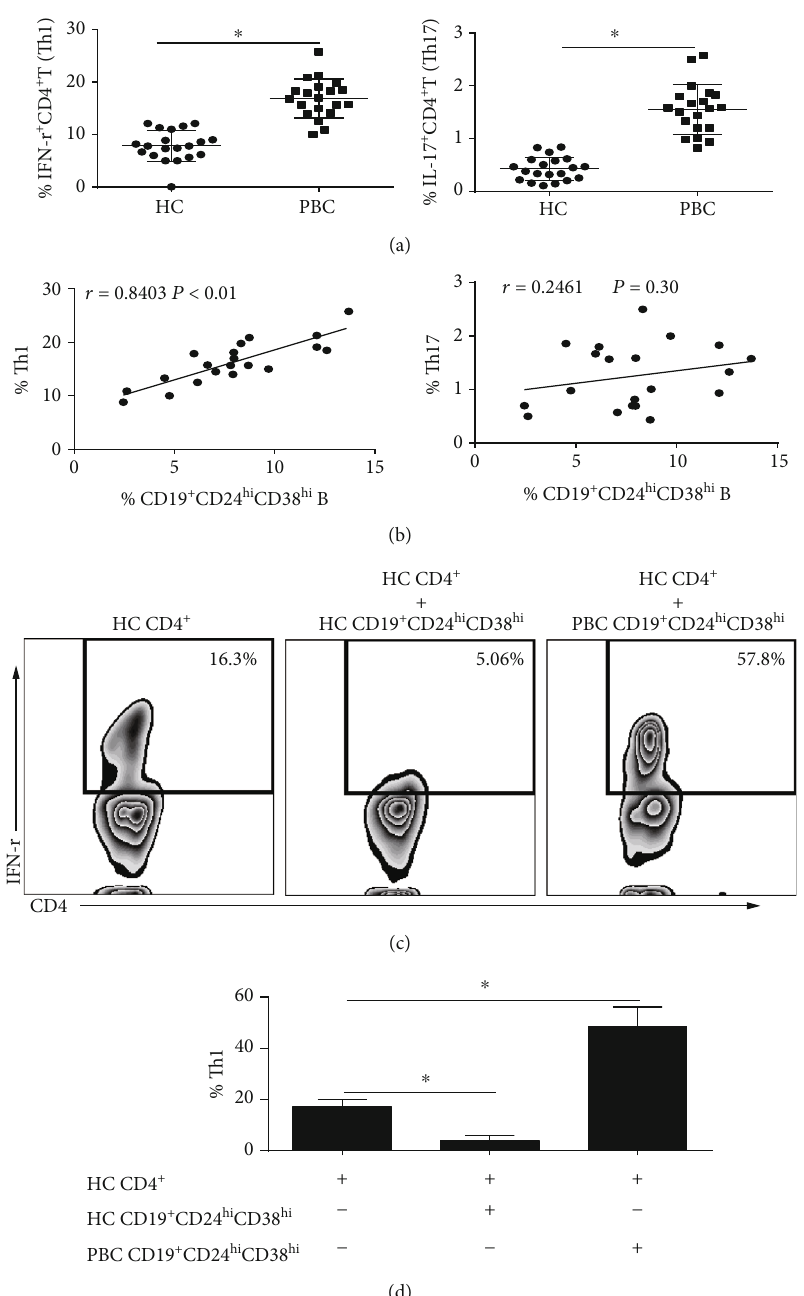
Figure 7: CD19 + CD24 hi CD38 hi B cells from PBC patients failed to suppress Th1 cell di ff erentiation, but promoted Th1 cell di ff erentiation. PBMC isolated from PBC patients or HC subjects were divided into two populations. One was stained with CD19, CD24, and CD38 mAbs and assessed by fl ow cytometry. The other was stimulated with phorbol ester, ionomycin, and Brefeldin A for 6h, then surface stained with CD4 mAbs, permeabilized, and stained with IFN- γ or IL-17 mAbs and assessed by fl ow cytometry. (a) Graphs showing the frequency of Th1 and Th17 cells from 20 PBC patients and 20 HC subjects. (b) Correlation between CD19 + CD24 hi CD38 hi B cell frequency and Th1 or Th17 cell frequency from PBC patients. (c, d) CD19 + CD24 hi CD38 hi B cells from PBC patients and HC subjects were sorted by fl ow cytometry and then cocultured with HC subject subset CD + T cells for 6 D, and Th1 cell frequency was measured by fl ow cytometry. Representative (c) contour plots and (d) graphs showed healthy CD19 + CD24 hi CD38 hi B cells suppressed autologous Th1 cell di ff erentiation, while PBC CD19 + CD24 hi CD38 hi B cells promoted HC Th1 cell di ff erentiation. The data are representative of four separate experiments; ∗ P < 0 : 05